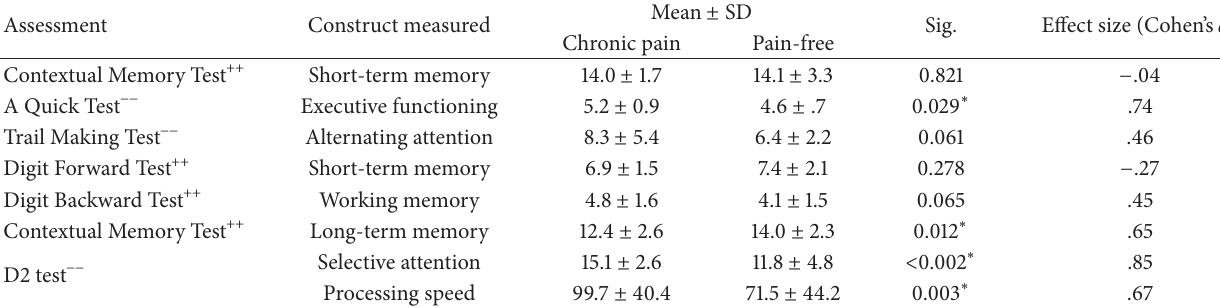
Table 3: Results of pain and cognitive